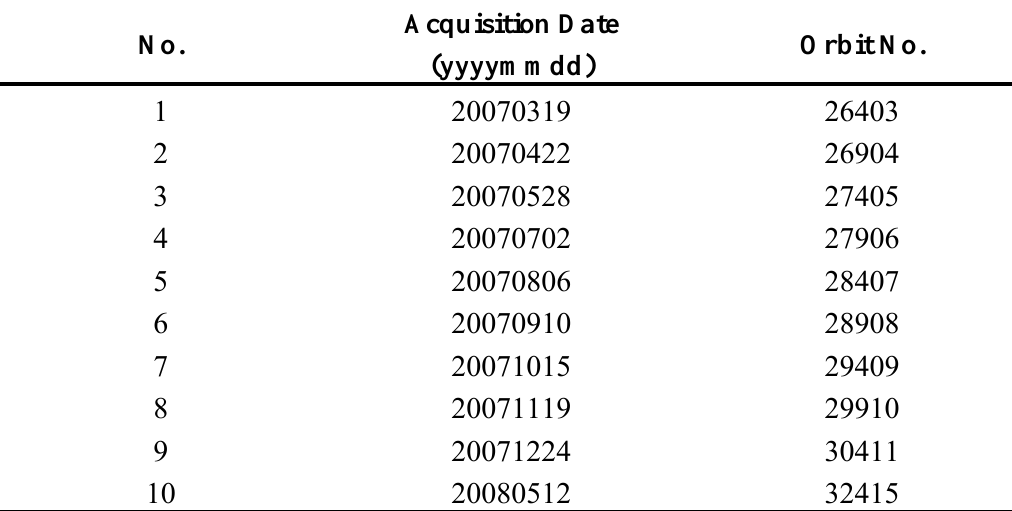
Table 1. Image Mode ASAR Data used in this